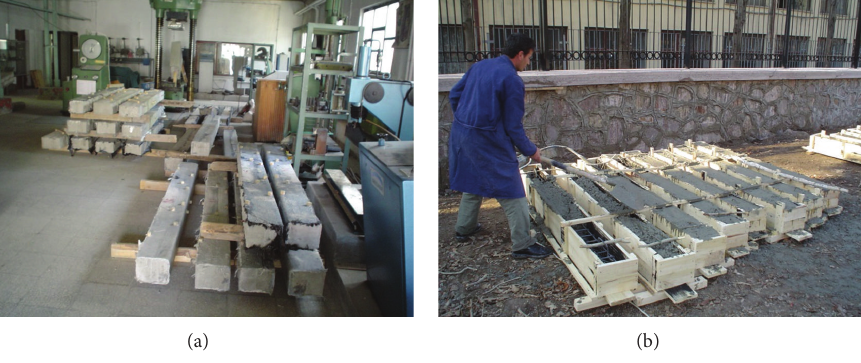
Figure 2: Preparation of experimental beams.